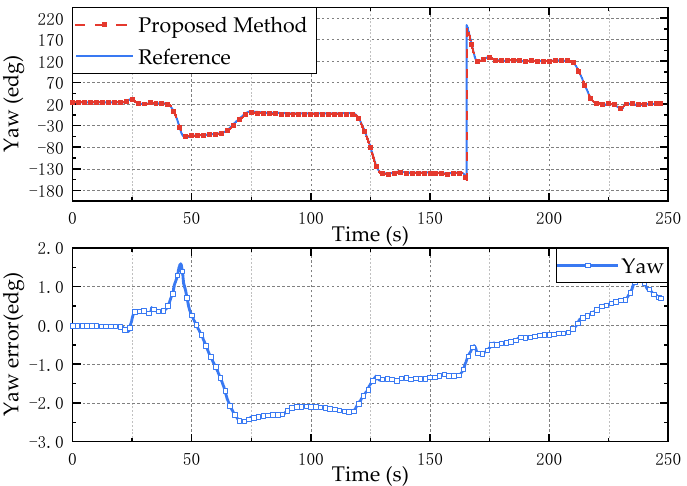
Figure 17. Yaw angle anti-interference test results. The above is the estimation result of the proposed method, and the bottom is the error between the estimated value and the reference value.